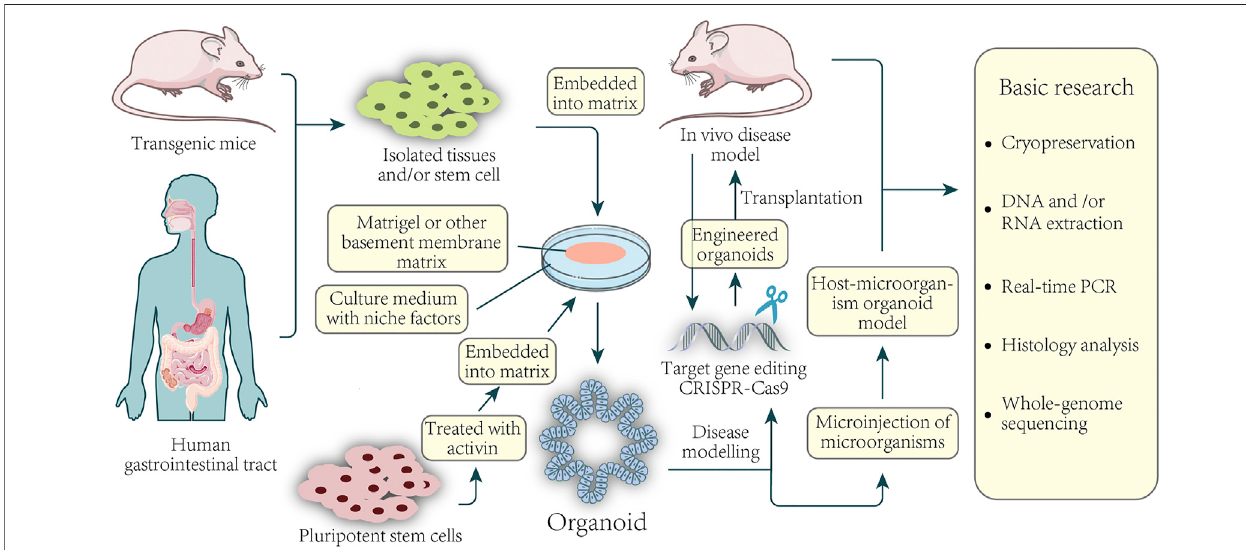
FIGURE 1 | Basic application of colorectal organoids in disease and basic research. Organoids can be established from healthy or CRC tissue from the patient- sourced samples.Isolated tissueorstemcells, oractivin-treated humanpluripotentstemcells,areembedded inabasementmembranematrixandmaintainedinmedia containing a variety of niche factors critical for expansion. Organoids are usually formed in 3D and have structures similar to their origin. For example, culturing isolated gastricepithelial cellsundertheconditionsdescribedabovecangrowhumangastricorganoids inwhichgastricglandzone budsaredistributedaroundthecentral lumen.Geneeditingoforganoidscanbeusedforthemodelingofdiseasesaswellastheconstructionofxenografts.Directsamplingthroughmiceandorganoidscanbe used for a series of fundamental studies.